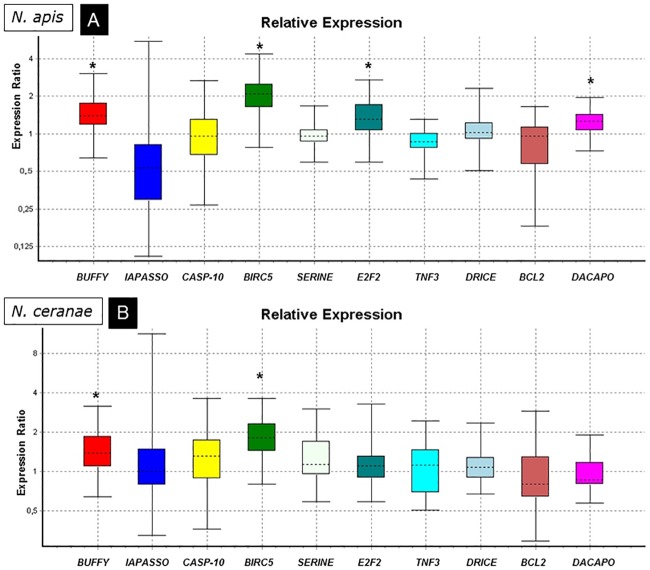
Relative expression ratio plots for apoptosis related genes.Analysis of groups treated with cycloheximide and infected with N. apis (A) or N. ceranae (B) relative to uninfected bees. (*) significant differences.